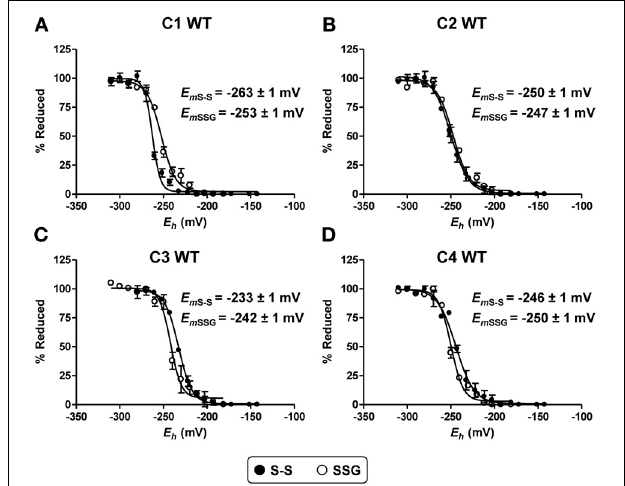
FIGURE 6 | Determination of redox potential of oxidized poplar GrxC1, C2, C3, and C4. Representative curve of oxidation-reduction titration of Cys A -Cys B intramolecular disulfide forms (black circles) and glutathionylated Cys A (white circles) forms of poplar GrxC1 (A) , GrxC2 (B) , GrxC3 (C) , and GrxC4 (D) at pH 7.0. The titration was carried out using a total DTT or GSH concentration of 2mM for 2h and resulting free thiol groups were labeled by mBBr. Values in the text are the means ± SD of three